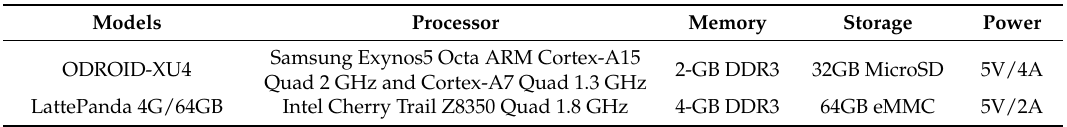
Table 4. Specifications for devices used in